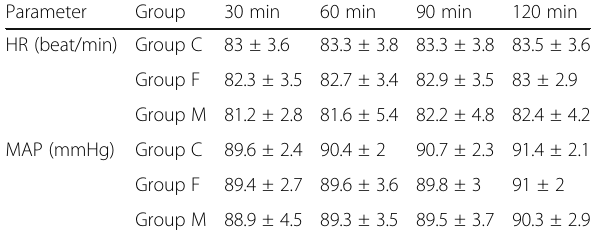
Table 3 Postoperative hemodynamic variables estimated in studied patients categorized according to injected